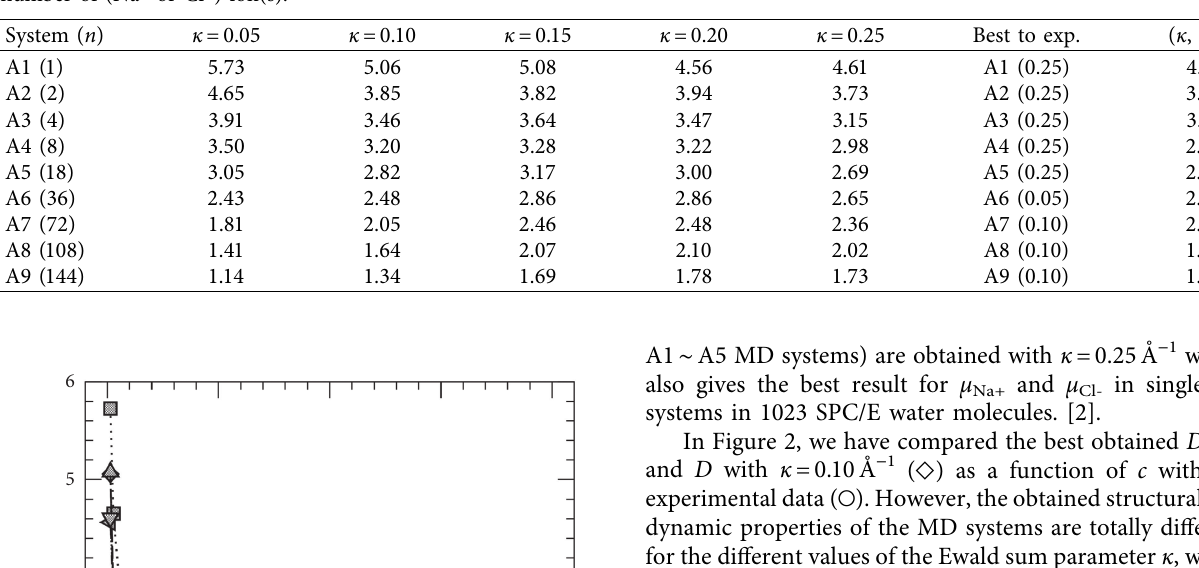
Table 3: Diffusion coefficients (D, 10 − 9 m 2 · sec − 1 ) of NaCl in SPC/E water at 25 ° C employing a velocity Verlet algorithm, where n is the number of (Na + or Cl − ) ion(s).